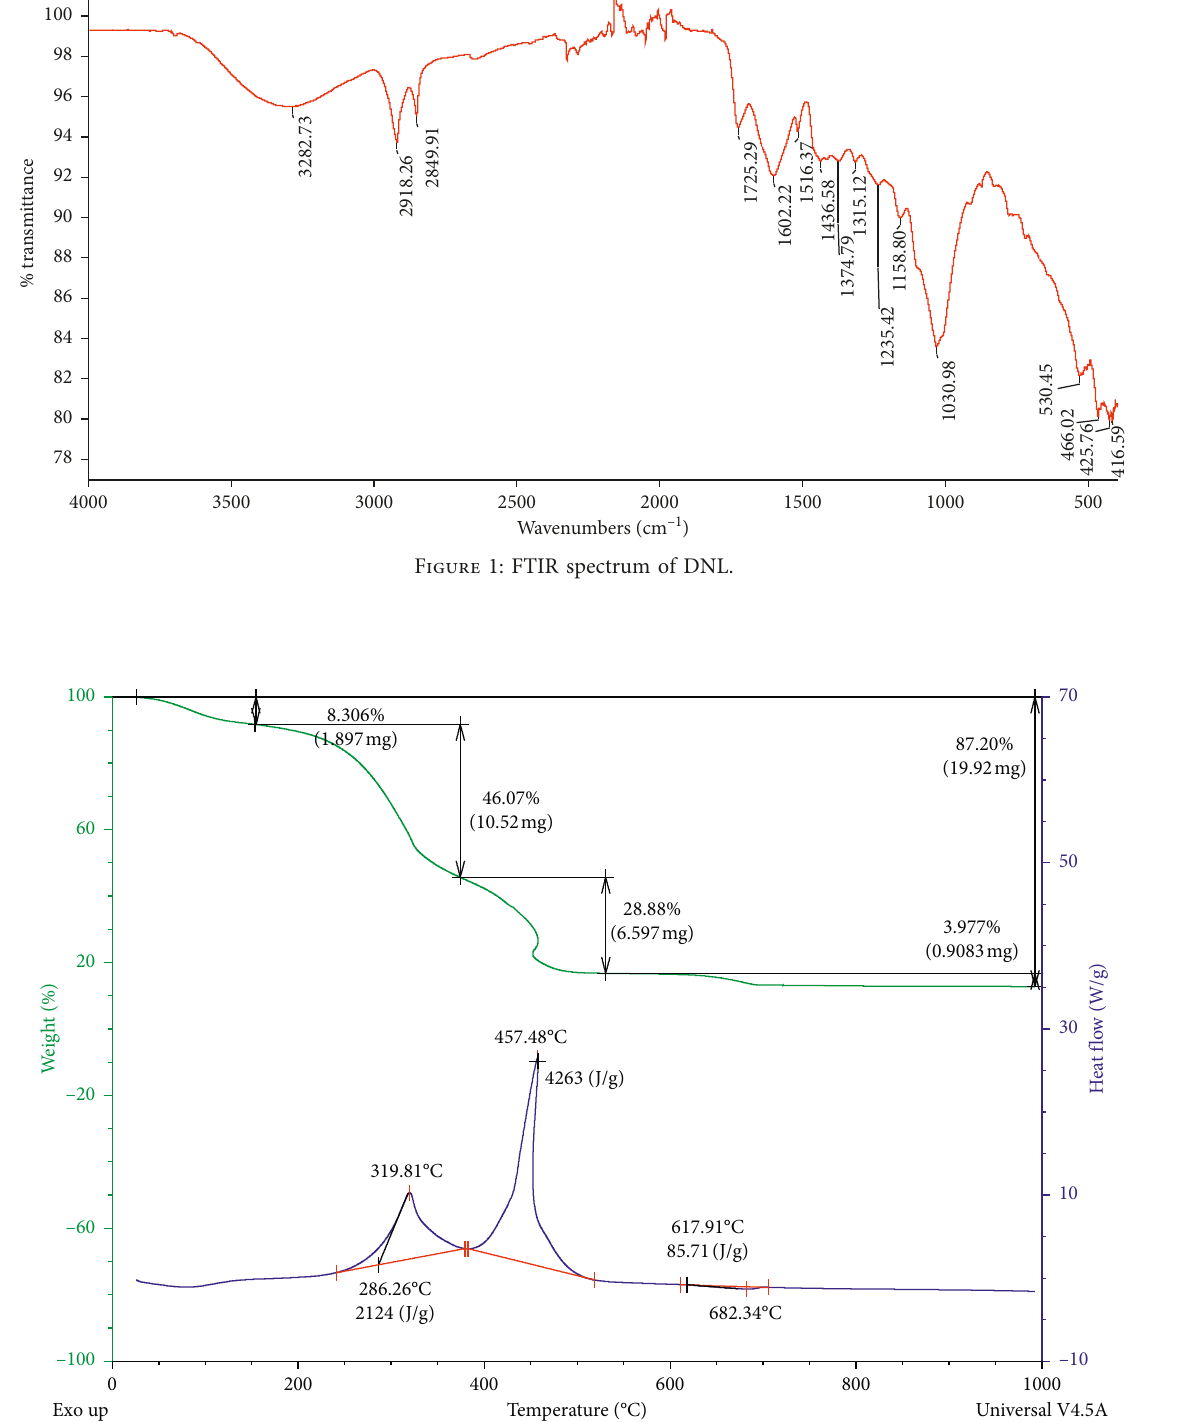
Figure 2: TG/DSC decomposition profile of